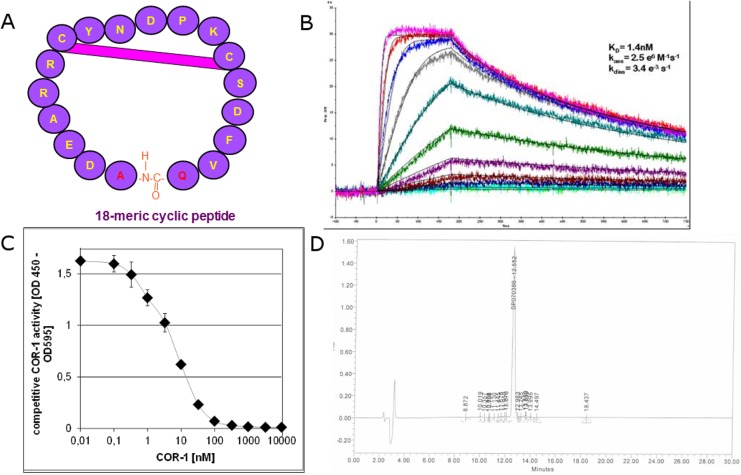
A. Cartoon demonstrating the structure of COR-1. B: Surface plasmon resonance. Representative tracing of the quantitative analysis of the interaction of COR-1 with the anti-ß1EC2–antibody 23-6-7 by surface plasmon resonance. Concentrations of 0.125 nmol/L to 128 nmol/L COR-1 were investigated at 30μl/min and 25°C. C: ELISA: Inhibition of binding of biotinylated 16-meric ß1EC2 peptides to the coated anti-ß1EC2 antibody 23-6-7 in the presence of increasing concentrations of COR-1 D: HPLC profile: HPLC shows one sharp peak of COR-1 and only few side products. COR-1 purity exceeds 95%.